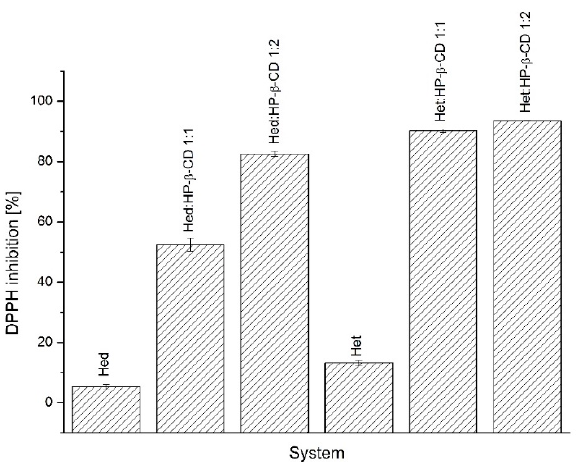
Figure 7. The results of the DPPH antioxidant assay of Hed and Het systems with HP- β -CD.